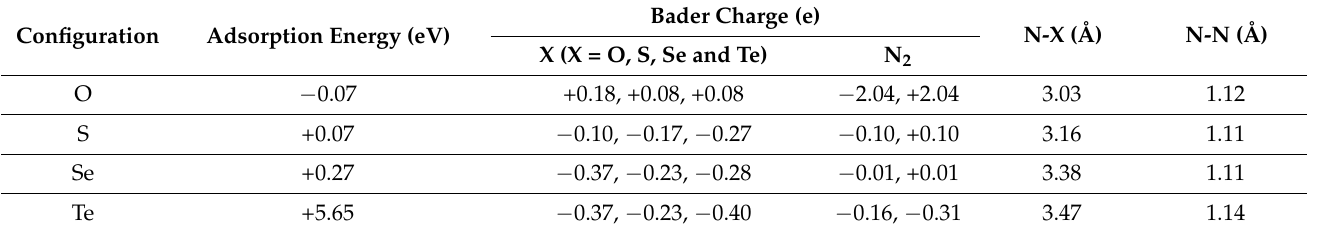
Figure 9. Relaxed structures of N 2 adsorbed onto the ( a ) O-, ( b ) S-, ( c ) Se- and ( d ) Te-doped graphene. Table 6. Calculated adsorption energies, Bader charges on the N 2 molecule, and adsorbed atoms (X) and bond distances (C-X and